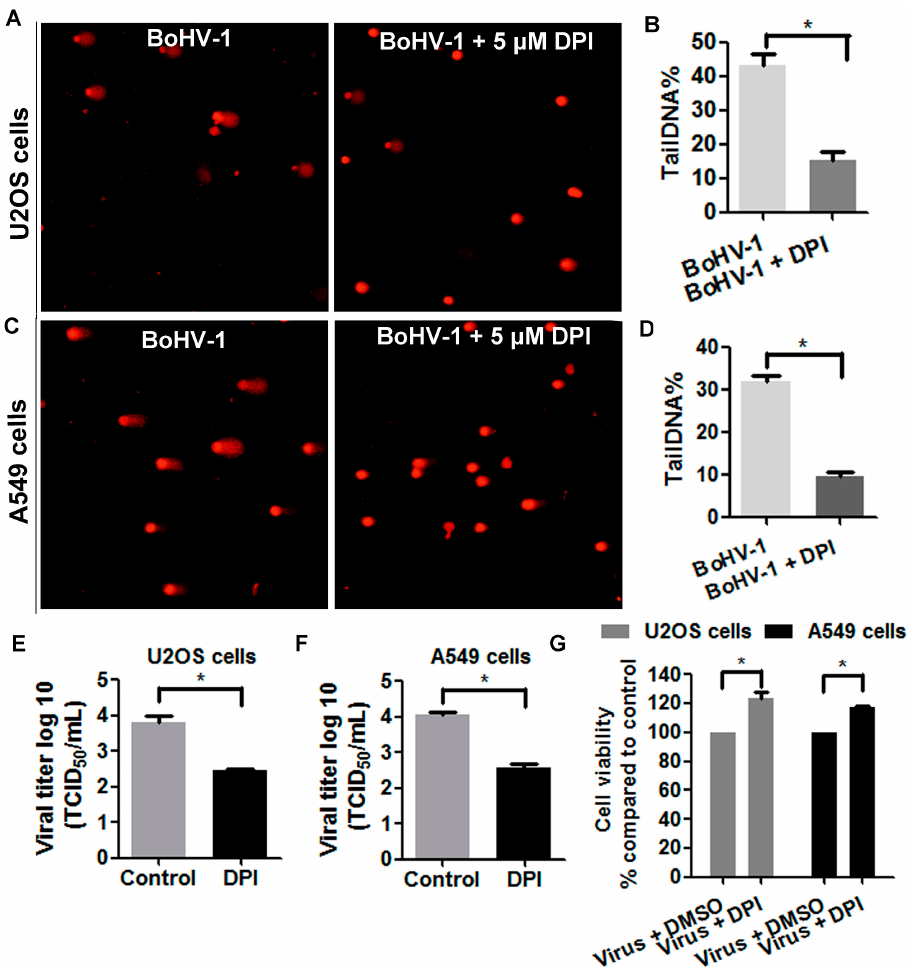
Figure 6. ROS was involved in BoHV-1-induced DNA damage in human tumor cells. ( A , C ) Both U2OS cells ( A ) and A549 cells ( C ) were infected with BoHV-1 (MOI = 0.1) and treated with DPI (5 μ M) or DMSO control. At 48 h after infection, DNA damage in individual cells was detected with comet assay. The images shown represent three independent experiments (Magnification ×200). ( B , D ) Three hundred cells from both U2OS cells ( B ) and A549 cells ( D ) treated with or without DPI were randomly selected for the analysis of tailDNA% with software CASP. Results are means of three independent experiments. *, Significant differences (P < 0.05) in tailDNA%, as determined by a Student t test. ( E , F ) Both U2OS cells ( E ) and A549 cells ( F ) were infected with BoHV-1 (MOI = 0.1) and treated with or without DPI (5 μ M). At 48 h after infection, the virus titers were detected using MDBK cells. *, significant differences (P < 0.05), as determined by a Student t test. ( G ) Both U2OS cells and A549 cells were infected with BoHV-1 (MOI = 0.1) and treated with DPI (5 μ M) or DMSO control. At 48 h after infection, the cell viability was determined by Trypan-blue exclusion test. Results are means of three independent experiments. *, Significant differences (P < 0.05), as determined by a Student t test. 4. Discussion Generally, DNA is under constant threat from multiple sources, including errors during DNA replication, products of intrinsic cellular reactions (e.g., ROS) and environmental factors such as UV radiation and chemical exposure [40]. Therefore, DNA damage is a common event in the life of a cell